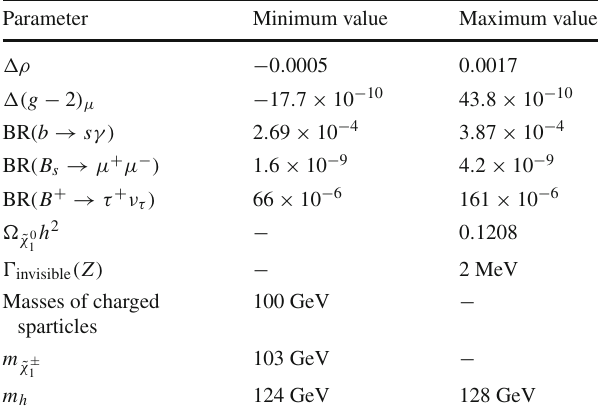
Table 3 Preselection cuts for the pMSSM benchmark points [6]